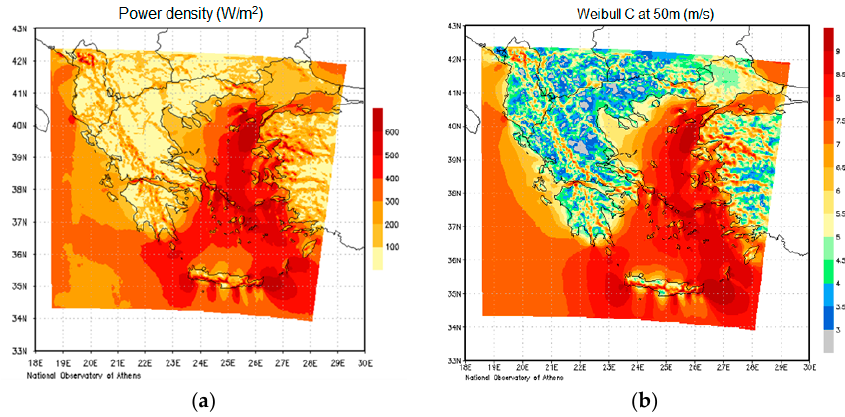
Figure 7. High resolution wind atlas based on typical wind year ( a ) power density (W/m 2 ) [19], ( b ) parameter c of Weibull distribution.